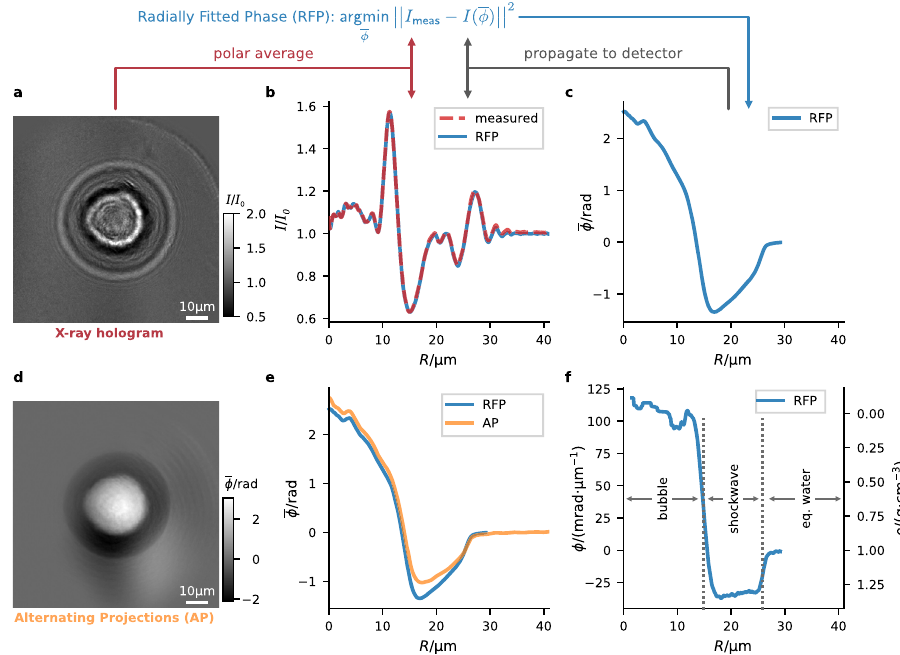
Fig. 2 Holographic phase retrieval and cavitation bubble density. a X-ray hologram (normalized intensity I / I 0 ) of a cavitation bubble at Δ t = 10 ns, exhibiting strong contrast at the inner interface (gas/shockwave) and outer interface (shockwave/equilibrium water). For phase retrieval, the hologram is averaged along the polar angle to obtain the radial intensity distribution. b Radial intensity distribution of ( a ) and intensity obtained from numerical propagation of the RFP retrieved phase (see ( c )). c In a forward model approach the projected phase ϕ of the bubble is retrieved by minimizing the difference to the radial intensity distribution (Radially Fitted Phase, RFP). d Retrieved phase of ( a ) using the AP algorithm, for comparison. The phase distribution re fl ects the de fi cit density in the core and excess density in the shockwave. e The average along the polar angle of the AP reconstruction is compared to the result obtained from RFP ( c ). f Radial three dimensional phase ϕ reconstructed from the RFP projected phase ( c ). The right ordinate shows the calculated density distribution of the cavitation bubble for an ellipticity factor ϵ ≈ 0.8. Scale bars: 10 μ m ( a , d